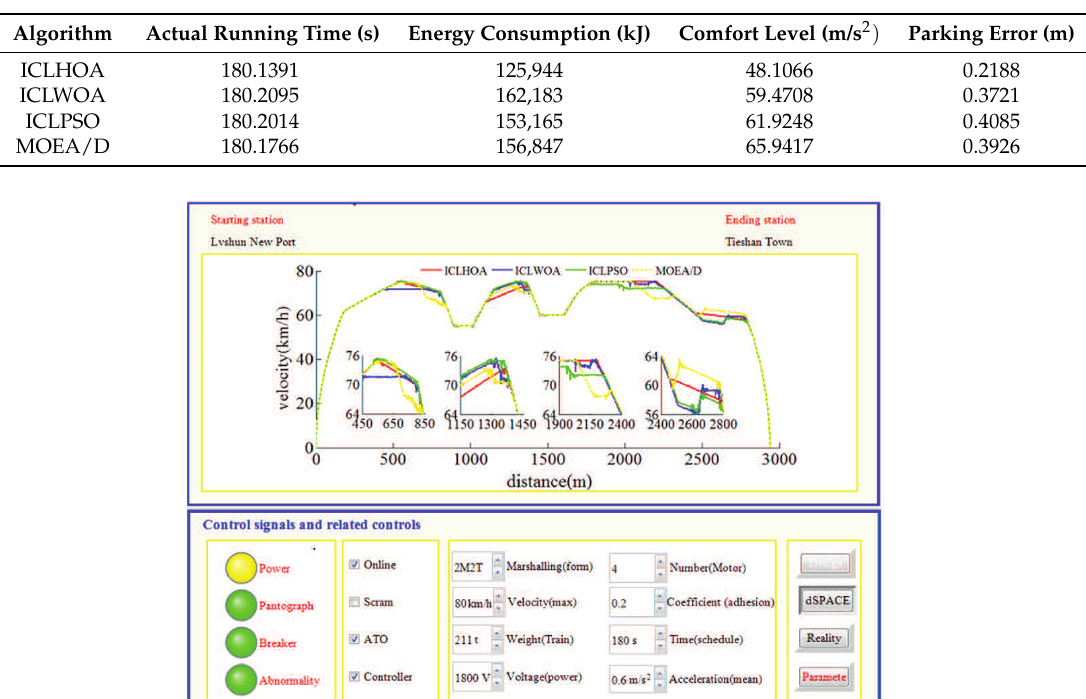
Table 8. The tracking fuzzy PID results of the velocity ideal trajectory profile obtained by partial algorithms under RCL-HILS.